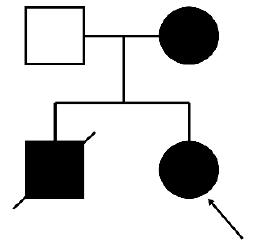
Figure 3. Pedigree of an Asian family with Danon disease. Arrow indicates the proband.